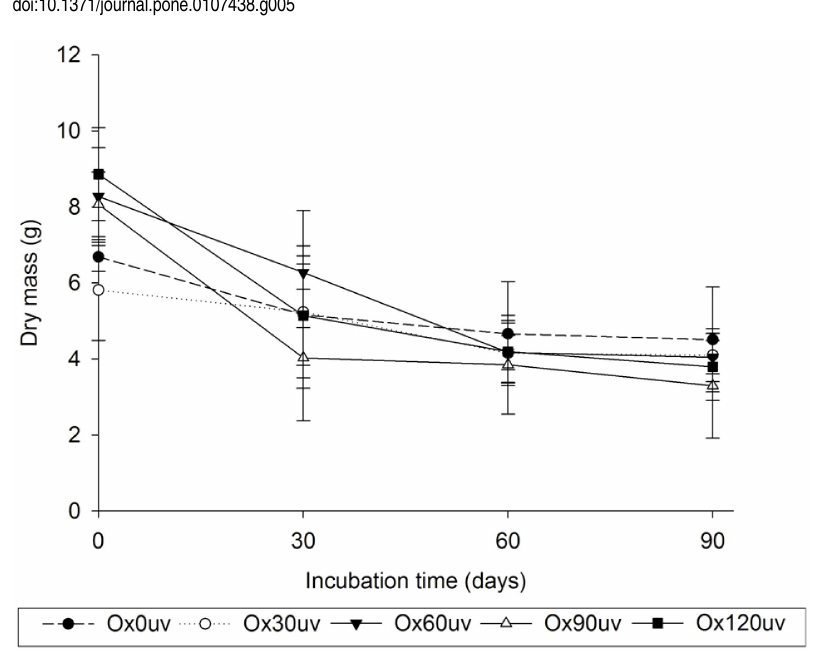
Figure 6. Dry mass of the substrates, used for 90 days of Pleurotus ostreatus growth, before (Ox0duv) and after 30 (Ox30duv), 60 (Ox60duv), 90 (Ox90duv) or 120 days (Ox120duv) of